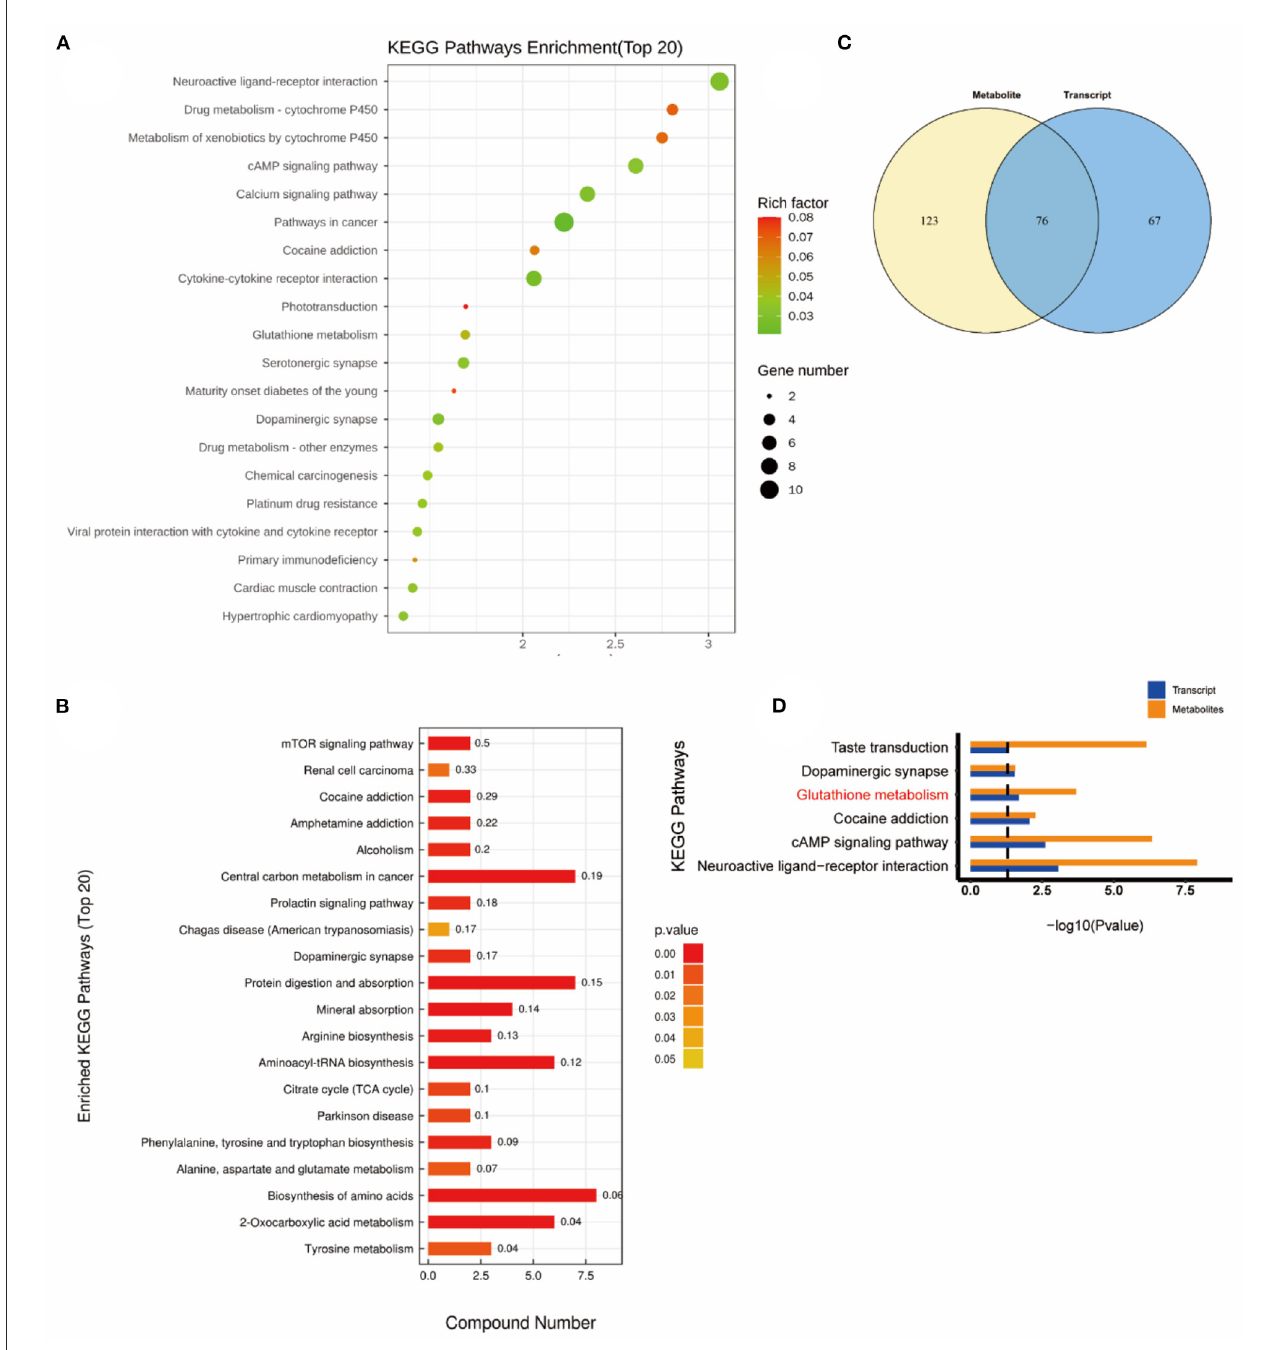
FIGURE9 KEGG pathway analyses of DEGs and DMs identified by comparing the H 2 group and the NEMP group. (A) KEGG pathway analyses of DEGs. (B) Venn diagram of the KEGG pathway involving DEGs and DMs. (C) Enrichment analysis of KEGG Pathway between DEGs and DMs. (D) Enrichment analysis of KEGG pathway between DEGs and DMs. N =